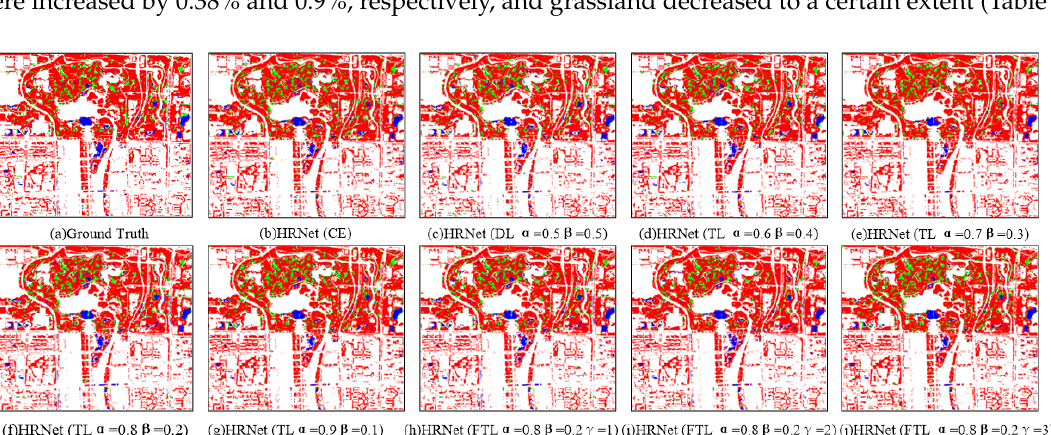
Figure 7. Comparison of the results of HRNet with Cross Entropy Loss, Tversky Loss, and Focal Tversky